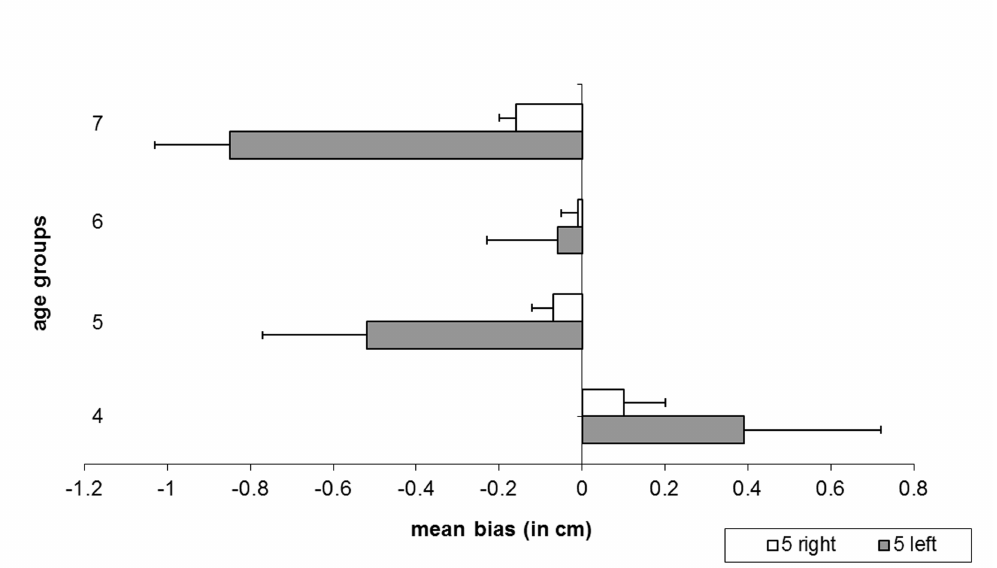
Figure 3. Line Bisection Task. Mean bias (mean deviation from zero in cm) for bisected lines with larger digit to its right (5 right) and larger digit to its left (5 left) as a function of age. Error bars represent standard errors of the